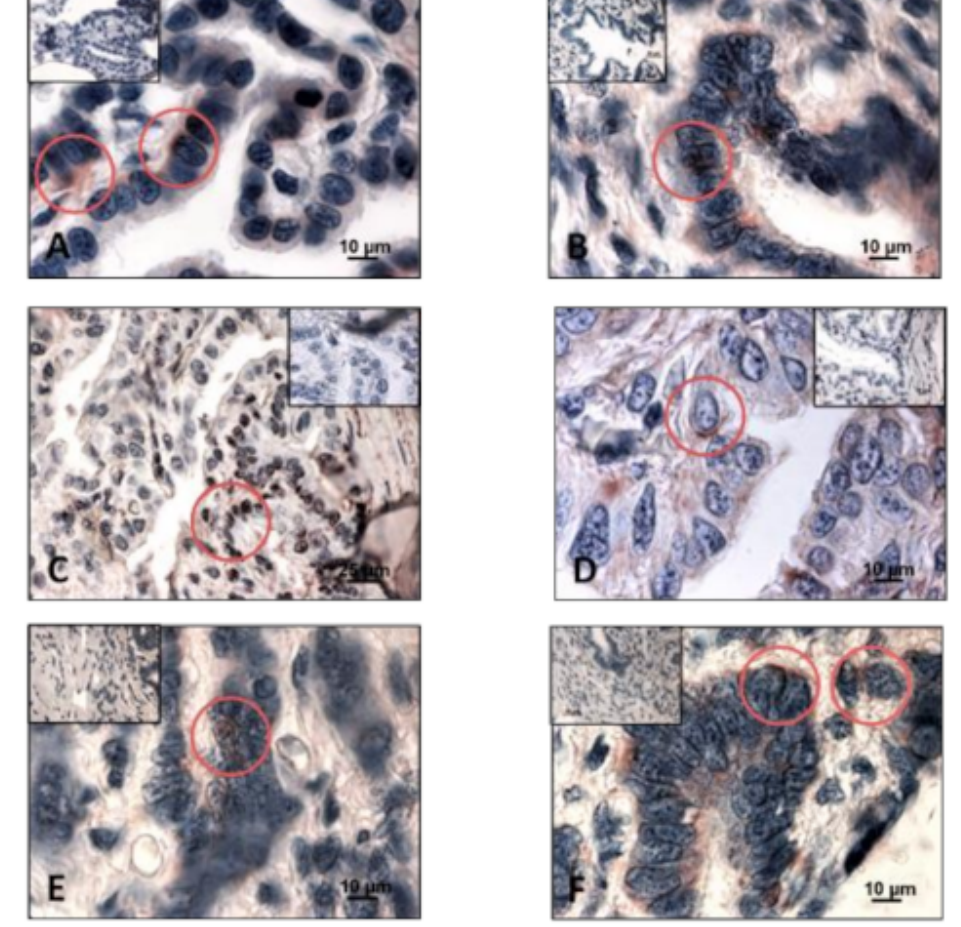
Figure 2. Examples of immunohistochemical reactions in Typhlonectes compressicauda genital tract. Red circles show positive labeling. Inserts show negative control. ( A ) Immunodetection of nuclear PR in cells of tubal part during the reproduction period; ( B ) Immunodetection of nuclear ER α in cells of uterus during the preparation of reproduction; ( C ) Immunodetection of nuclear ER β in cells of uterus during the reproduction period; ( D ) Immunodetection of FSHR in cells of uterus during the reproduction period; ( E ) Immunodetection of LHR in cells of uterus during the preparation of reproduction; ( F ) Immunodetection of PRLR in cells of uterus during the preparation of